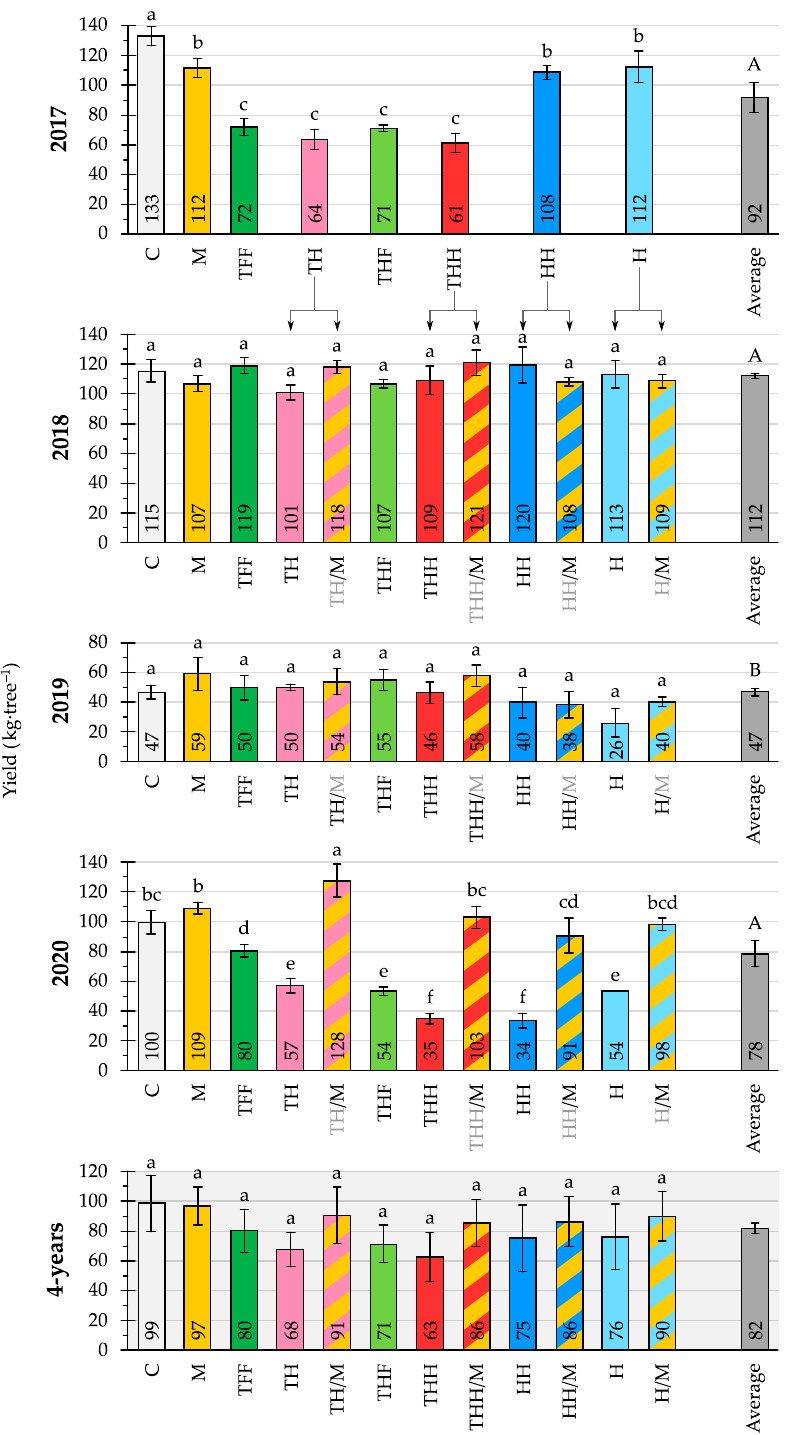
Figure 4. Yield (kg ∙ tree − 1 ) (average value—indicated numerically within the column—with standard error bar) by pruning strategy (1–12) and the average for all strategies, for each year and for the four years overall. Different lowercase letters above the bars for each year and four-year overall indicate significant differences (LSD test, p < 0.05). Different capital letters above the bars of the averages of all strategies for each year indicate significant differences (median notched box plot, p < 0.05).